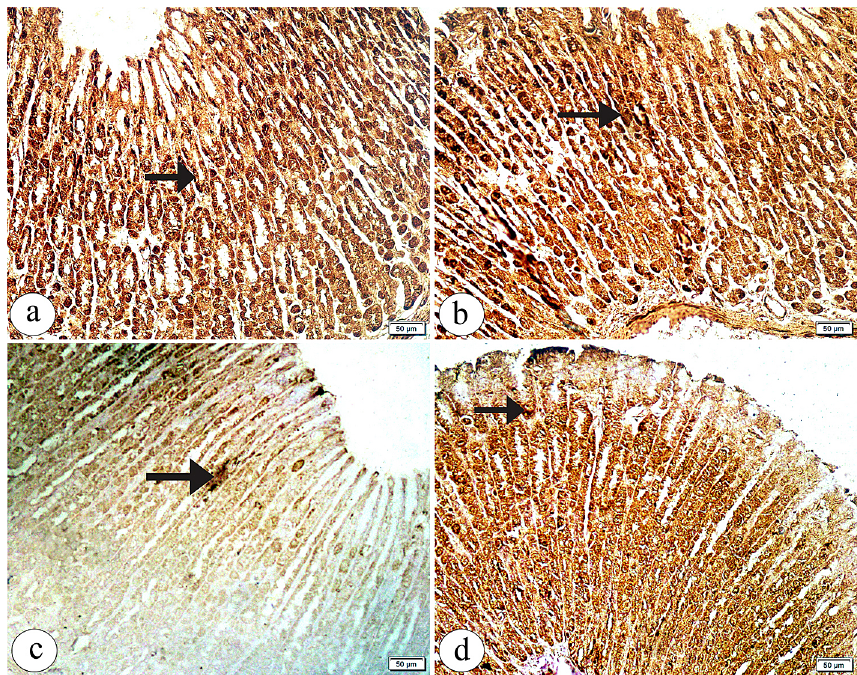
Figure 4. The photomicrographs of the sections in the glandular portion of the stomach in ( a ) the group Ӏ showing a positive BCL2 immunoexpression (arrow) in the gastric glands. ( b ) the group ӀӀ showing a positive BCL2 immunoexpression (arrow) more or less than the group Ӏ . ( c ) the group ӀӀӀ showing an apparent decrease in the positive BCL2 immunoexpression (arrow) as compared to the group Ӏ ( d ) the group Ӏ V showing an apparent increase in the positive BCL2 immunoexpression (arrow) as compared to the group ӀӀӀ . (BCL2 immunohistochemical staining × 200, Scale bar = 50 µm).